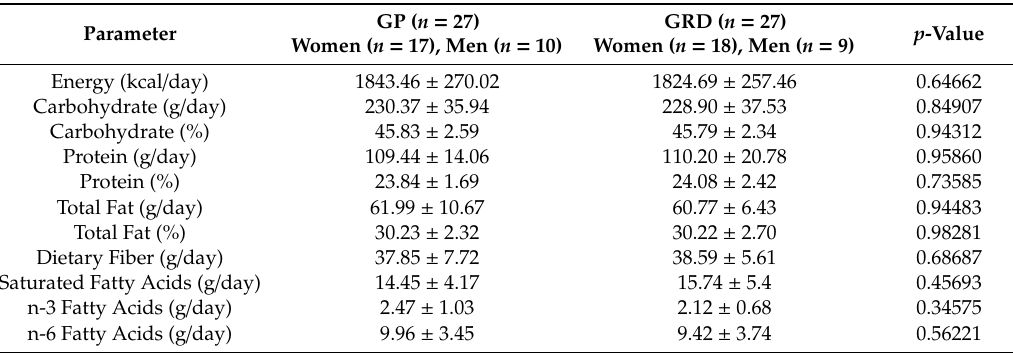
Table 2. Daily consumption of energy and selected nutrients by the studied